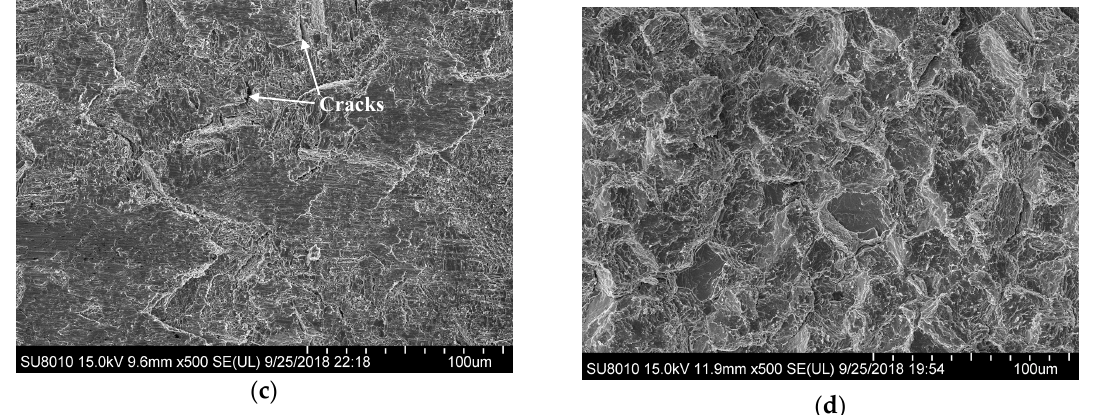
Figure 6. SEM images of the ( a , b ) cross section and the ( c , d ) fracture surface of TLP-bonded GH4169/BNi-2/GH4169 joints at 1040 °C ( a , c ) and 1080 °C ( b , d ).